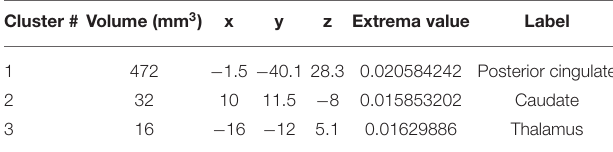
TABLE 3 | Co-activated clusters about alcohol, nicotine, and illegal drug. Cluster # Volume (mm 3 )